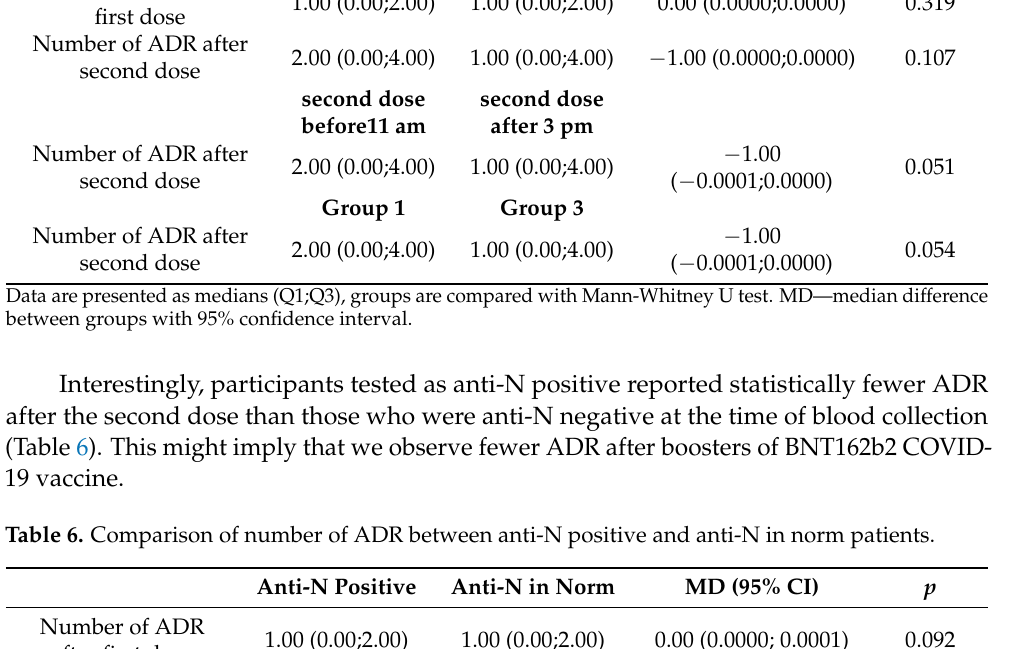
Table 5. Comparison of number of ADR between patients who received first dose before 11:00 and after 15:00. Studied Population MD (95% CI) p Group 1 + 2 Group 3 + 4 Number of ADR after first dose Number of ADR after